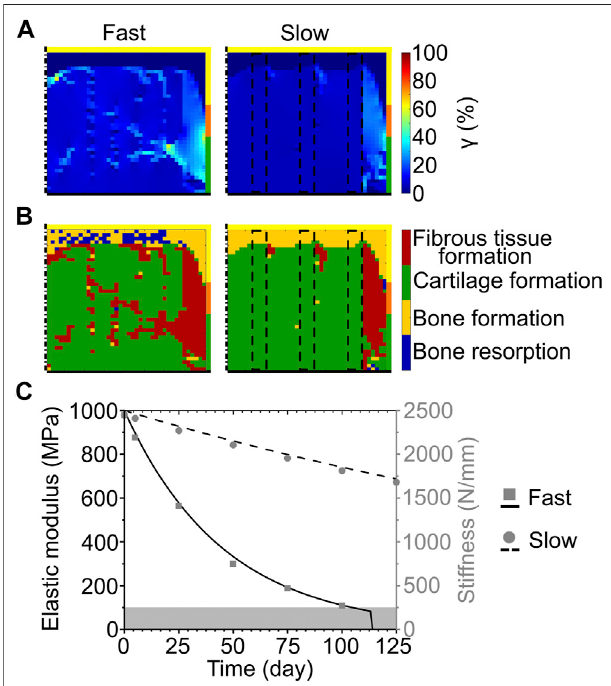
FIGURE 5 | In fl uence of scaffold degradation with exponential bulk degradation on osteochondral defect repair. (A) Distribution of octahedral shear strain ( γ ); (B) prediction of tissue formation based on the mechanical stimulus ( S ). All images refer to day 125. The right column shows the outcome obtained with the exponential degradation rate of porous PCL and PDLLA scaffolds (slow), while the left column refers to porous PLGA scaffolds (fast). The yellow, orange, and green borders indicate the neighboring healthy tissuesofcancellousbone,subchondralbone,andcartilage,respectively.The dash-dot and solid black lines highlight the axis of symmetry and the articular surface, respectively. The black dashed lines mark the scaffold struts; (C) Materialelasticmodulusandscaffoldstiffnessduringdegradationwiththefast and slow exponential degradation rate. The grey area marks the region of concomitanterosion.Linesandsymbolsrefertoelasticmodulusandstiffness,